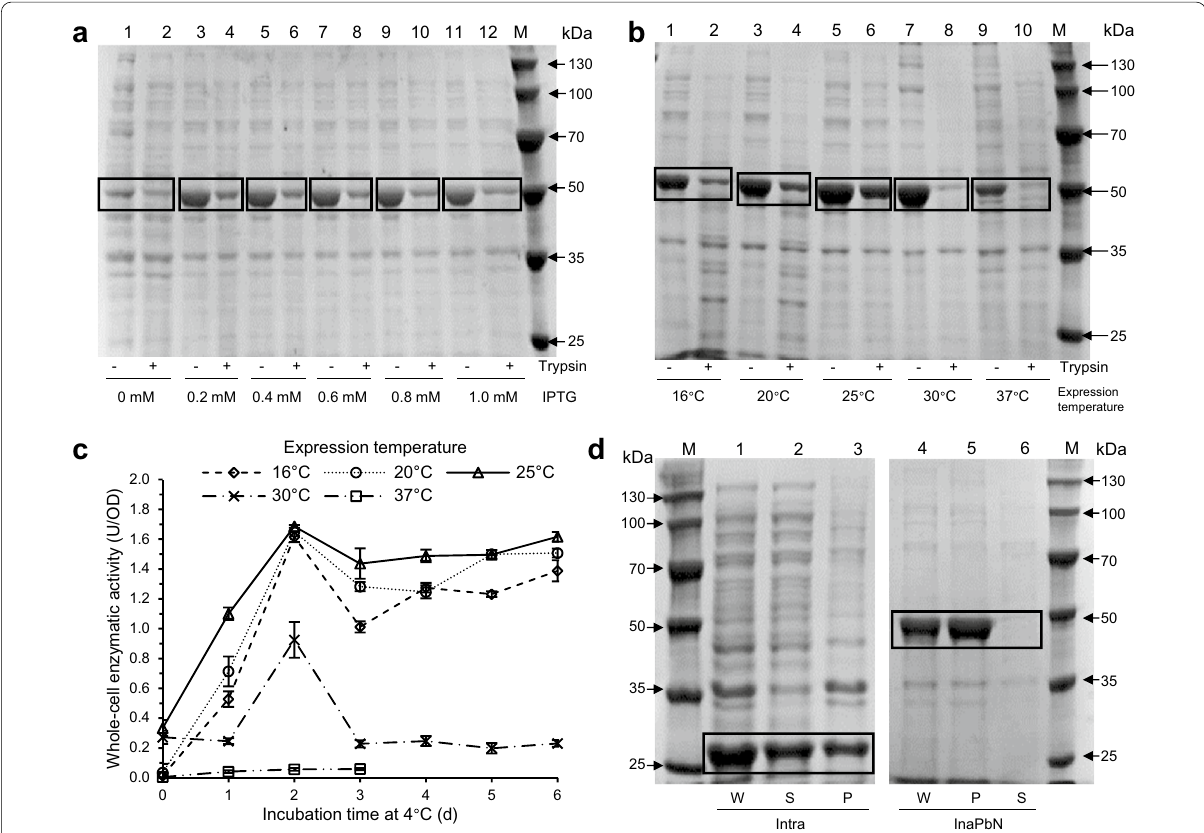
Fig. 2 SDS-PAGE analysis of the InaPbN-CESH[L] expression. a The effect of the inducer IPTG concentrations. Lanes 1–12, each pair of lanes are trypsin-untreated and treated whole cells induced by IPTG with the concentrations of 0.0 mM, 0.2 mM, 0.4 mM, 0.6 mM, 0.8 mM, and 1.0 mM. Lane M, standard protein molecular weight markers. b The effect of the expression temperature. Lanes 1–10, each pair of lanes are trypsin-untreated and treated whole cells with the expression temperatures 16 °C, 20 °C, 25 °C, 30 °C, and 37 °C. Lane M, standard protein molecular weight markers. c The whole-cell enzymatic activities of InaPbN-CESH[L] with different expression temperatures. d Fraction analysis of intracellular expressed CESH[L] (lanes 1–3) and displayed InaPbN-CESH[L] (lanes 4–6). W, whole-cell lysate; S, supernatant after centrifugation of the cell lysate; P, pellet after centrifugation of the cell lysate. Lane M, standard protein molecular weight